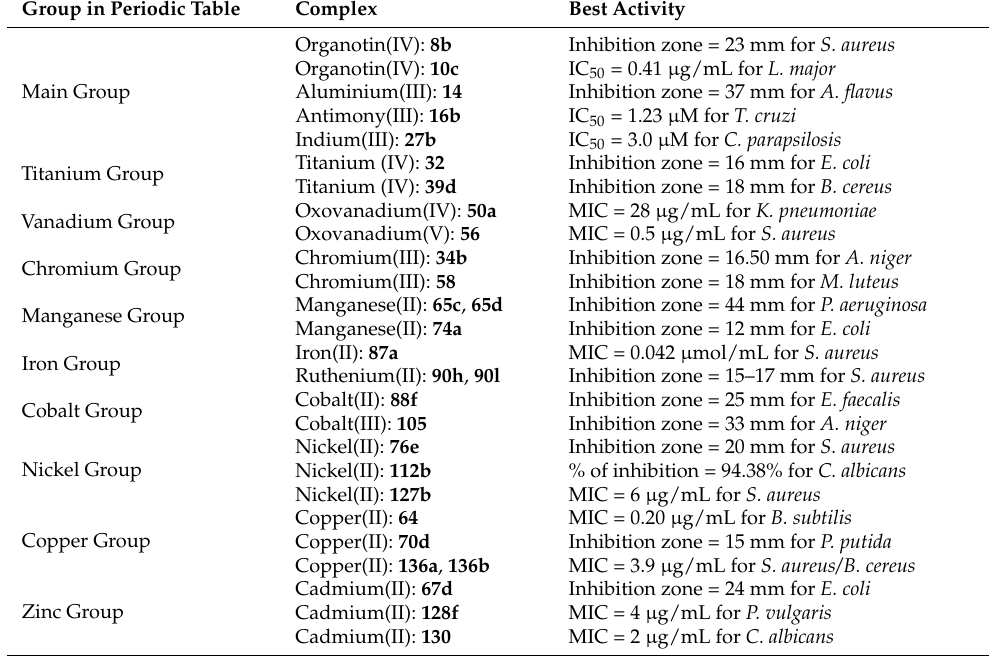
Table 1. Comparison of the pincer complexes derived from tridentate Schiff bases with best antimi- crobial